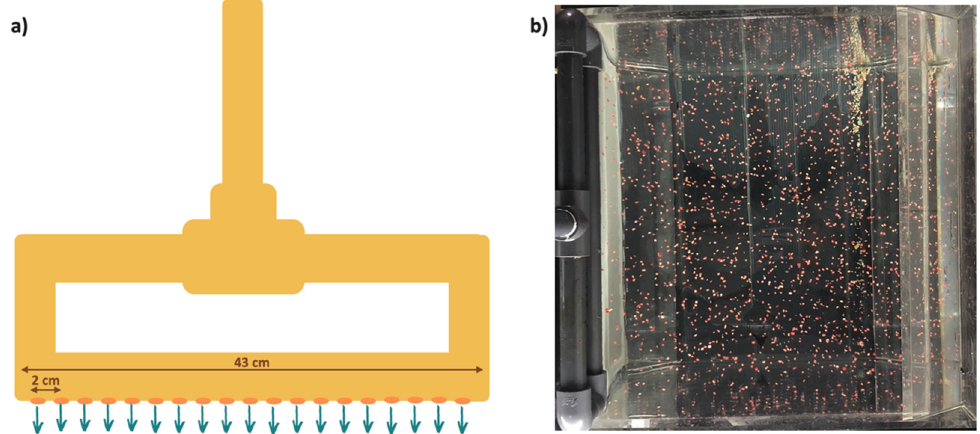
Figure 2. Optimised inlet pipe design ( a ); top view picture of the tank under optimised conditions ( b